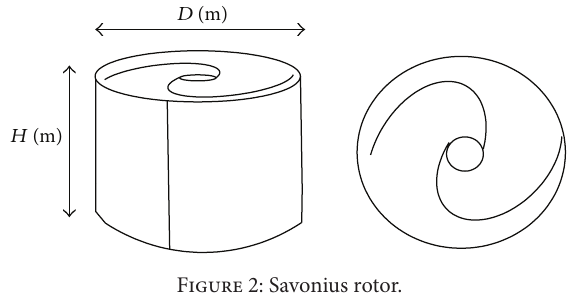
Figure 2: Savonius